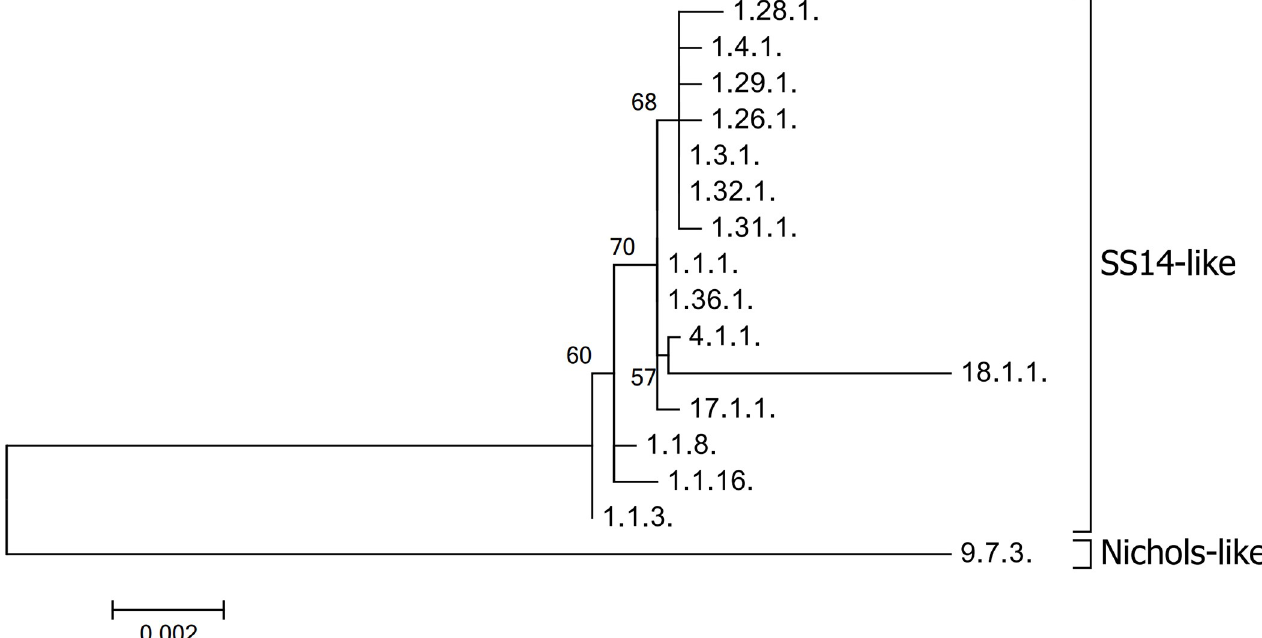
Fig 2. A phylogenetic tree of allelic profiles identified among fully typed samples. The scale shows the number of substitutions per site. Bootstrap values are shown next to branches. The length of concatenated sequences was 2593 bp and contained 95 variable positions. The tree was constructed in MEGA7 [24] using the Maximum Likelihood method [25] with the bootstrap test [26].